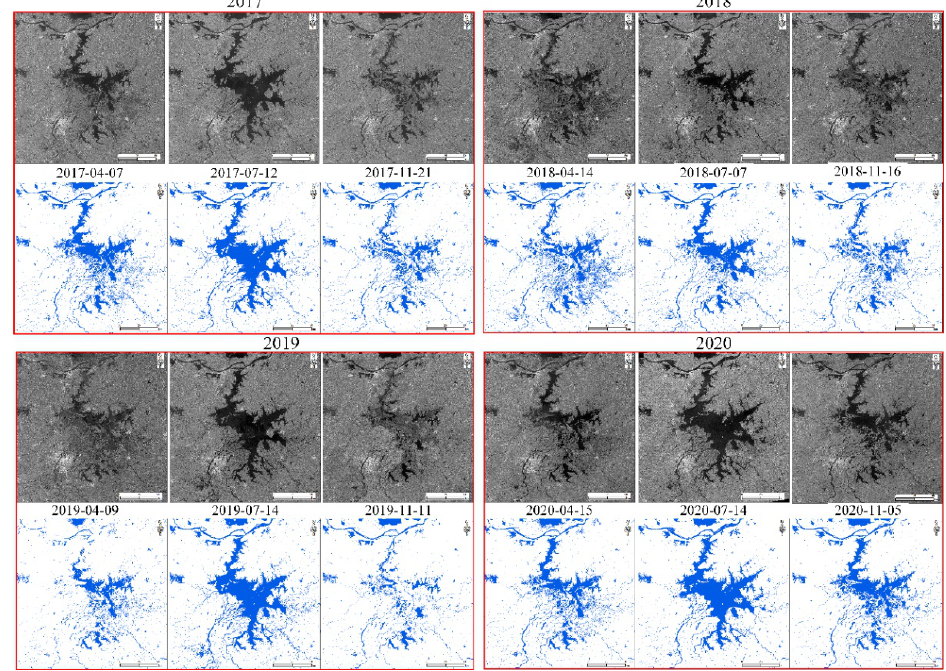
Figure 11. Results of pre-, during-, and post-flood of Poyang Lake in 2017–2020.